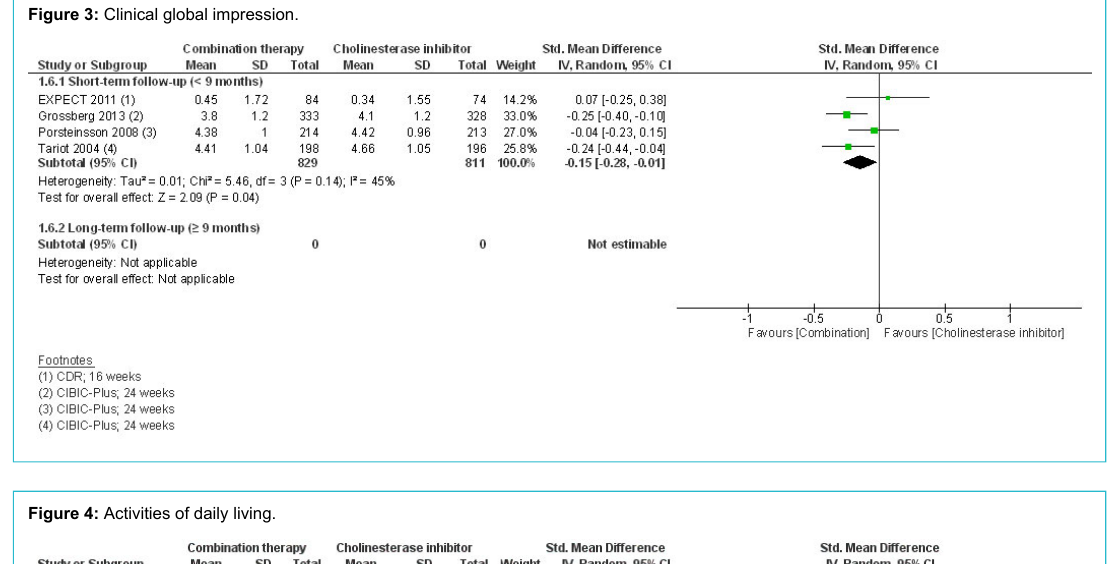
Figure 3: Clinical global impression.